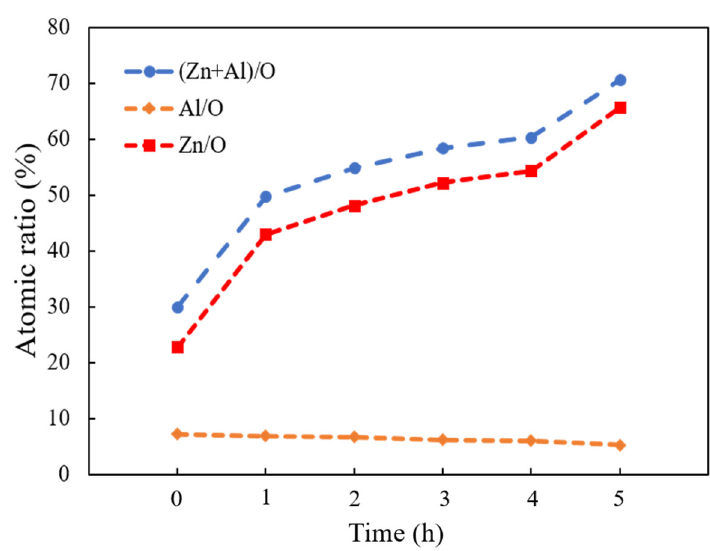
Figure 3. Variations of (Zn + Al)/O, Zn/O, and Al/O atomic ratios calculated from EDX analysis of as ‐ deposited AZO film and ZnO nanorods with different reaction times by CBD method.